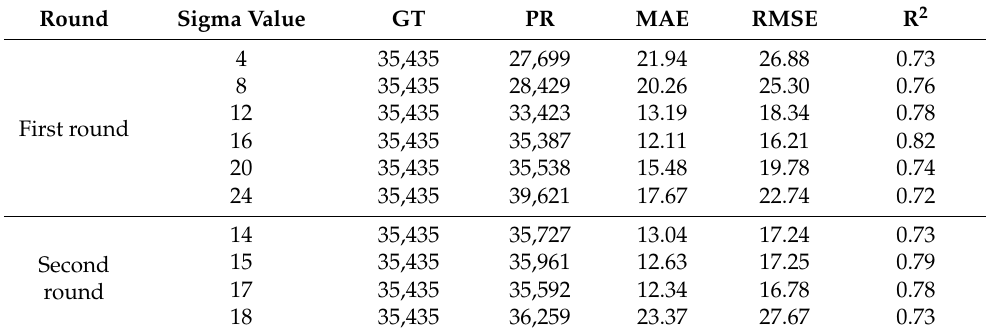
Table 3. The sensitivity analysis results of the sigma values evaluated using the validation dataset.